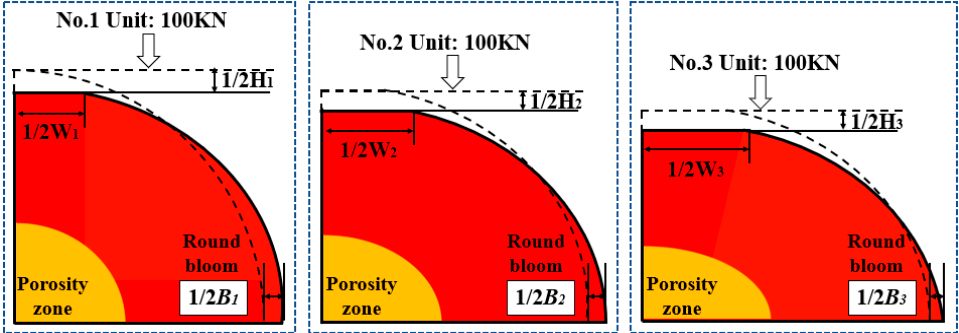
Table 1. Reduction parameters during soft reduction process.